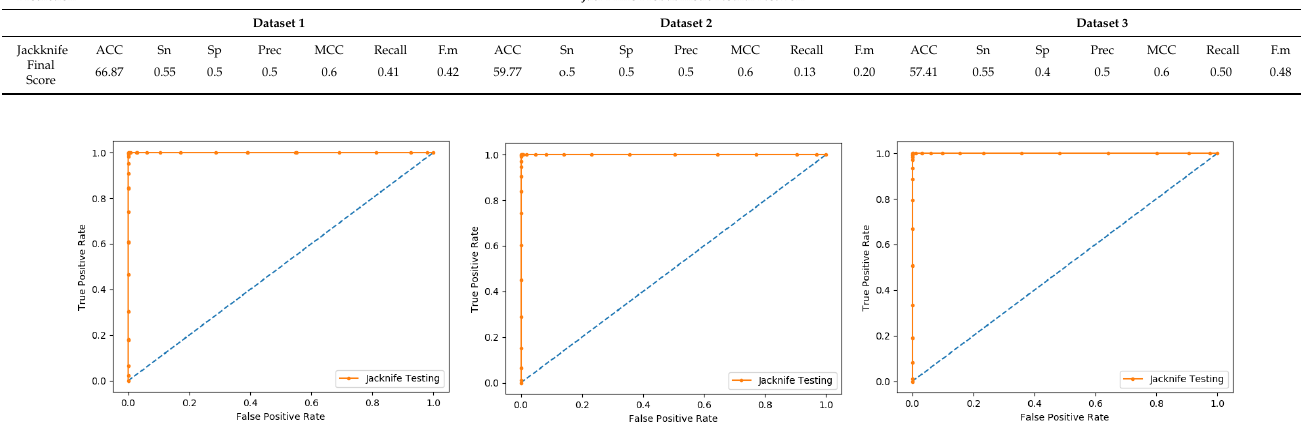
Figure 8. Jackknife Random Forest ROC curve.